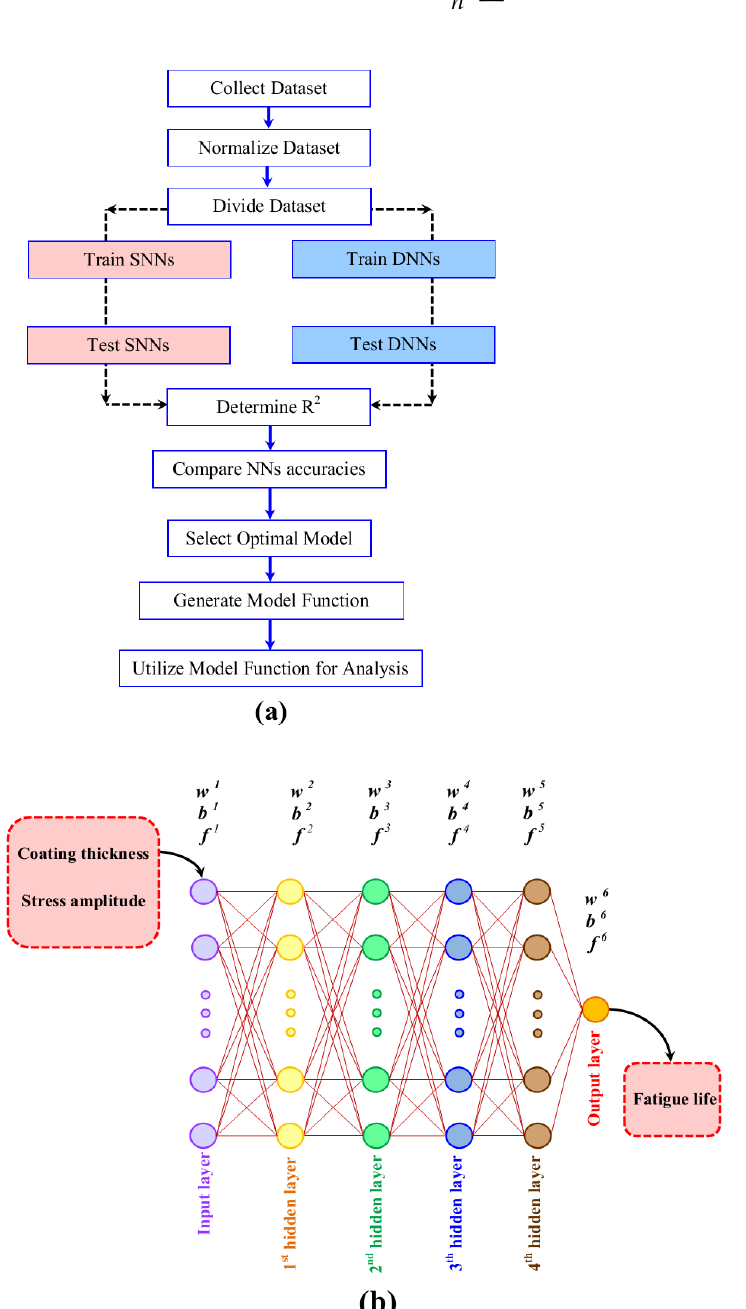
Figure 3. ( a ) Employed methodology and ( b ) Schematic of a DNN with four hidden